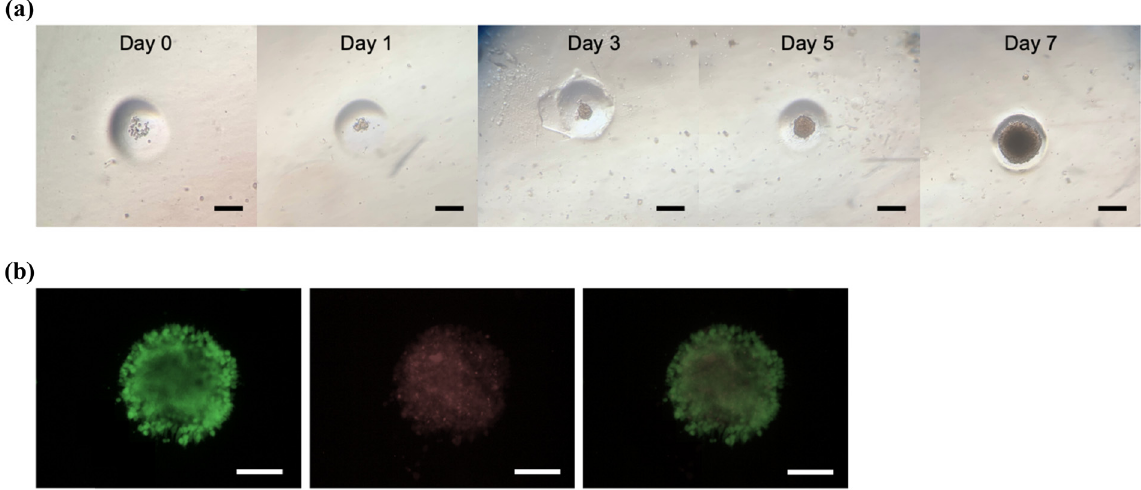
Figure 5: ( a ) Timeline images of cancer spheroids formation from day 0 to day 7 ( scale bar 100 µm ) , and ( b ) fl uorescence images of cancer spheroid staining with live cells ( 4 mM Calcein - AM, green ) , dead cells ( 2 mM ethidium homodimer - 1, red ) , and merged image of cancer spheroid ( scale bar = 100 µm ) .